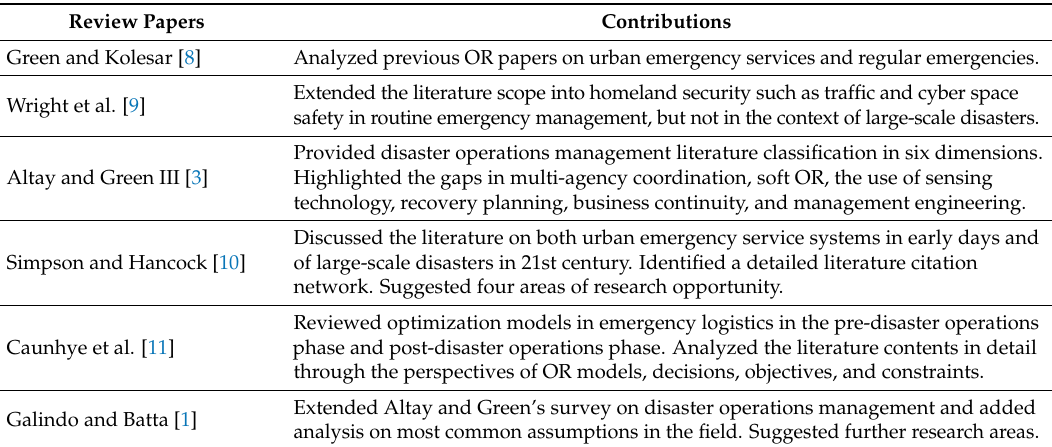
Table 1. Summary of review papers on emergency